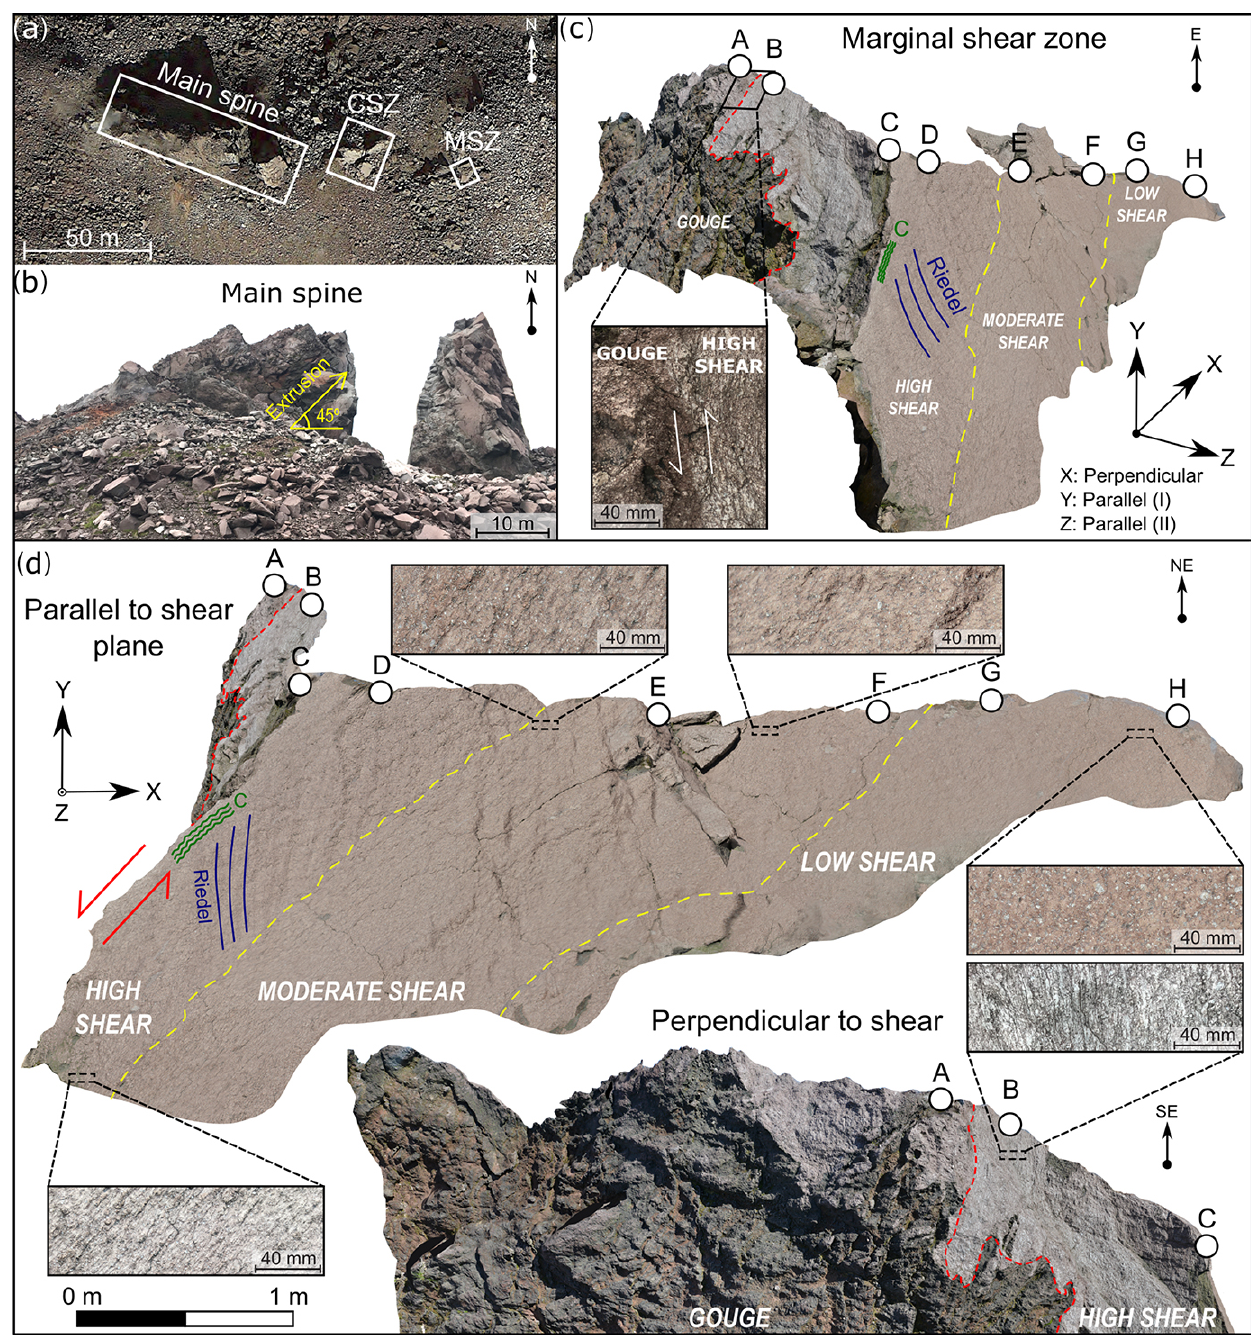
Figure 2. Location of the lava spine blocks and characteristics of the marginal shear zone. (a) An aerial view of Unzen lava dome summit showing the remnants of the 1994–1995 lava spine, including the main spine, the central shear zone (CSZ) block, and the marginal shear zone (MSZ) block. (b) Photograph of the main spine inclined towards the east. (c) 3D construction of the marginal shear zone block (created using the photogrammetry 3DF Zephyr by 3Dflow). The outcrop is annotated to show the location of samples (A–H) as well as the four main regions (gouge as well as high, moderate, and low shear zones) and key features, including the fault contact (red dashed curve), shear zone transitions (yellow dashed curves), extension of tensile fractures (C; green lines), and Riedel fractures (blue curves). The inset shows details of the fault plane, dividing the gouge and high shear zone. (d) View of the MSZ block parallel to the shear plane and perpendicular to the shear plane. Insets show surface textures across the shear zone. Directional arrows X , Y , and Z show the orientation of sample coring relative to the shear